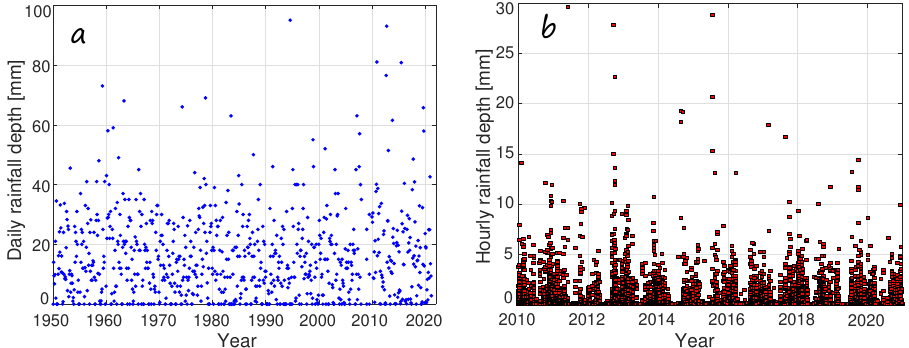
Figure 3. Maximum values of daily ( a ) and hourly ( b ) precipitation depth recorded 1950–2022 and 2010–2022, respectively. Data source: http://www.chguadalquivir.es/saih/, accessed on 1 July